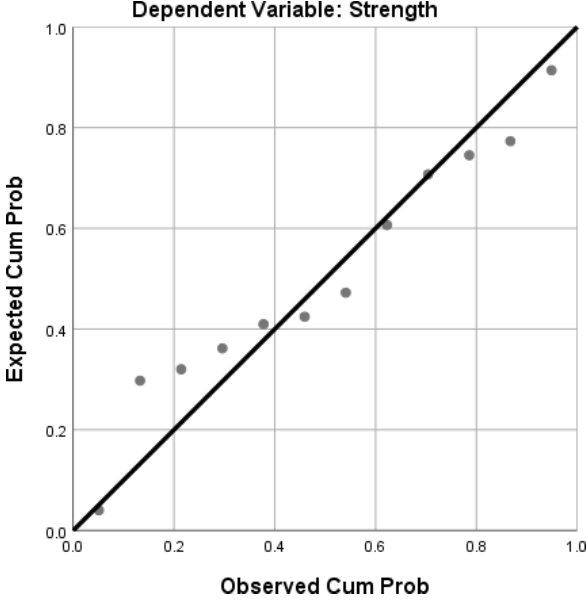
Figure 4: Normal P-P Plot of Regression Standardized Residual for Dependent Variable Strength